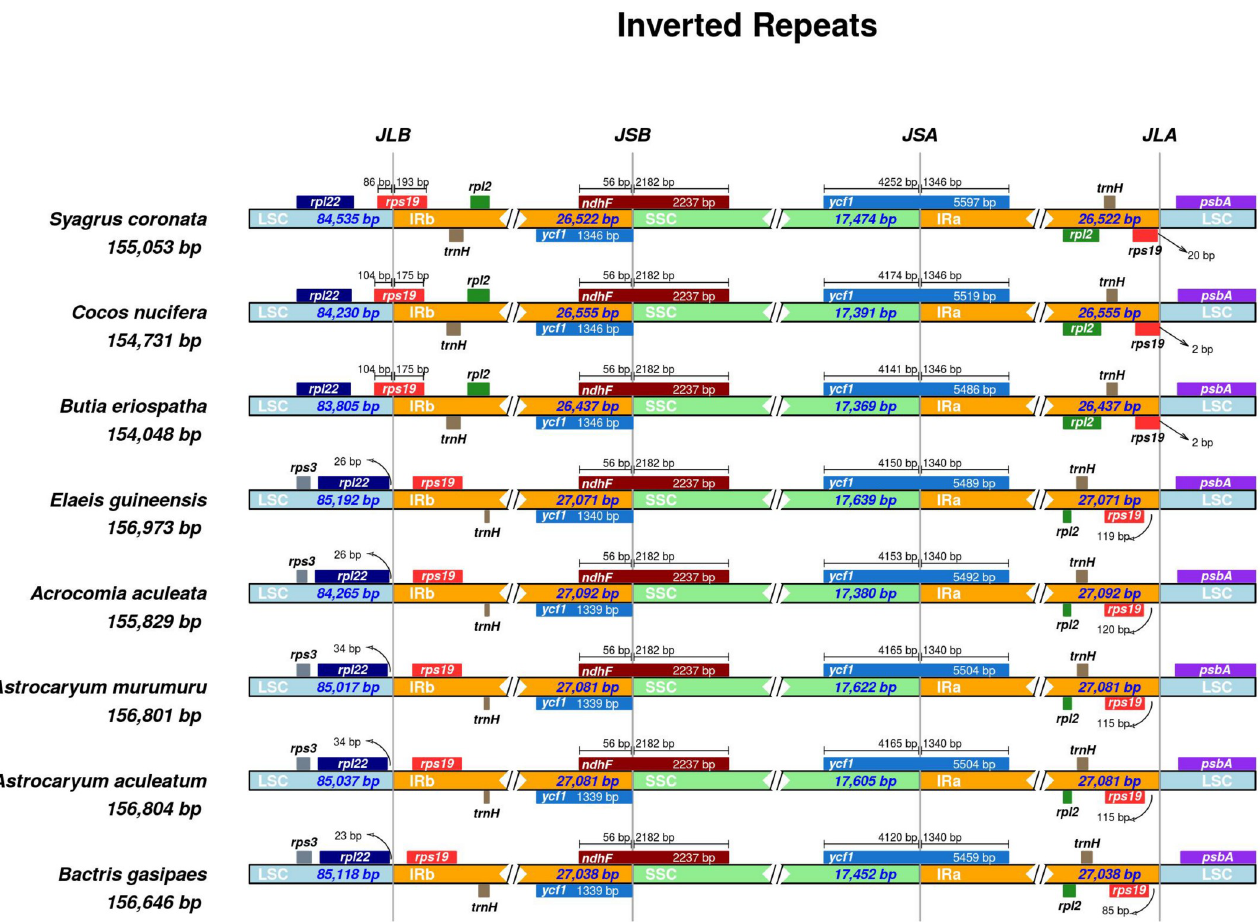
Fig 2. Comparison of plastome junctions (IRb/LSC; IRb/SSC, SSC/IRa; IRa/LSC) among Cocoseae species. The numbers indicate sequence length in base pairs.